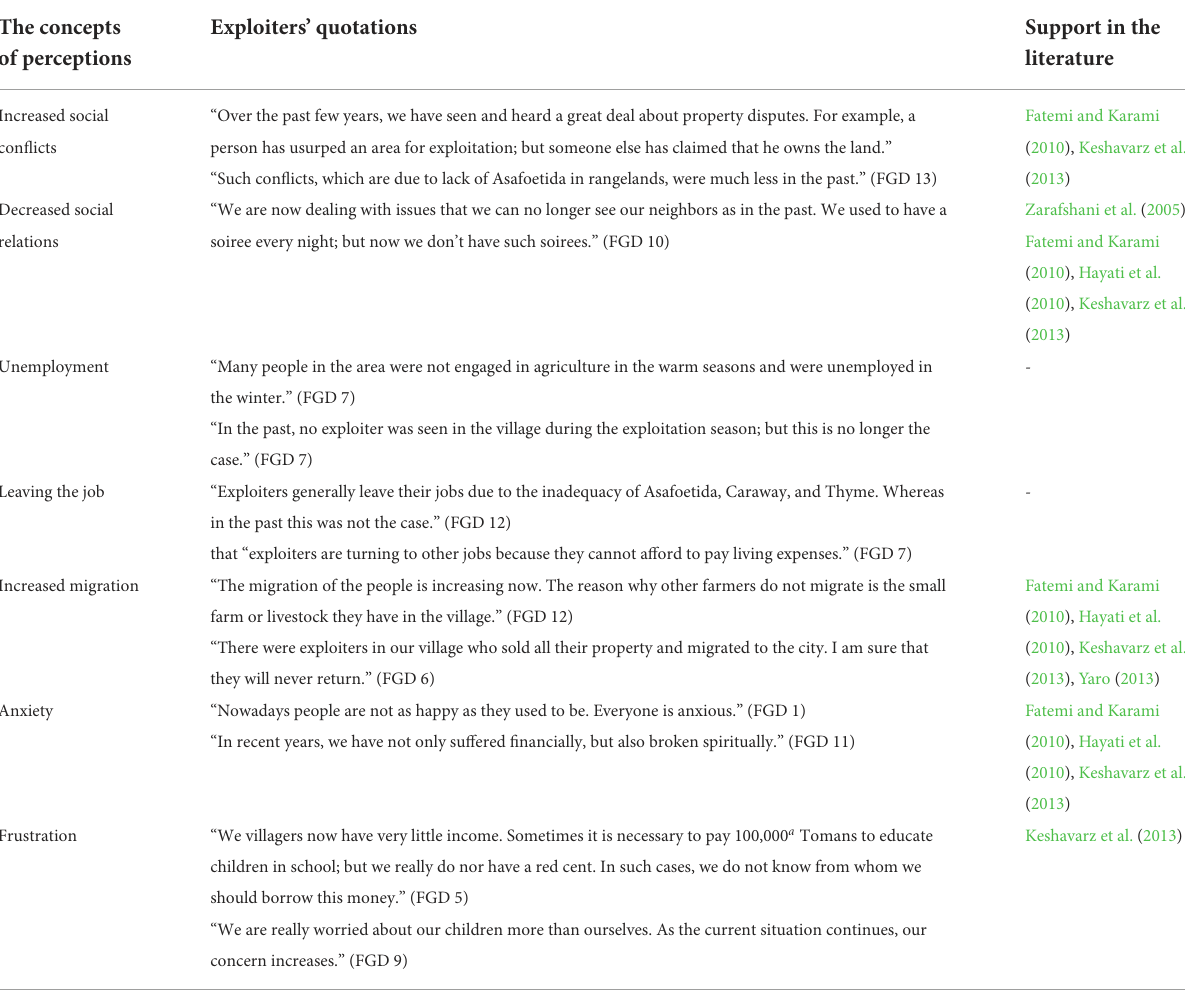
TABLE 3 Medicinal plant exploiters’ perceptions about social–psychological